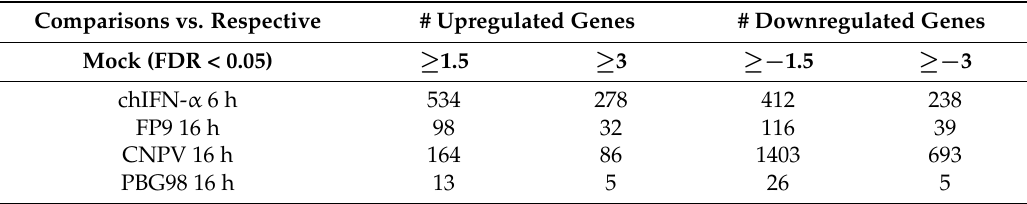
Table 1. Matrix showing differentially expressed transcripts identified from RNA-sequencing analysis of cESC following treatment (chIFN- α -stimulation or virus infected). Comparisons were normalised against respective mock controls. Numbers of significant genes are indicated for fold change in expression ≥± 1.5 and ≥± 3 and for false discovery rate (FDR) ≤ 0.05 (Unpaired T-test with Asymptotic p -value computation and Benjamini–Hochberg Multiple Testing correction). Comparisons vs.